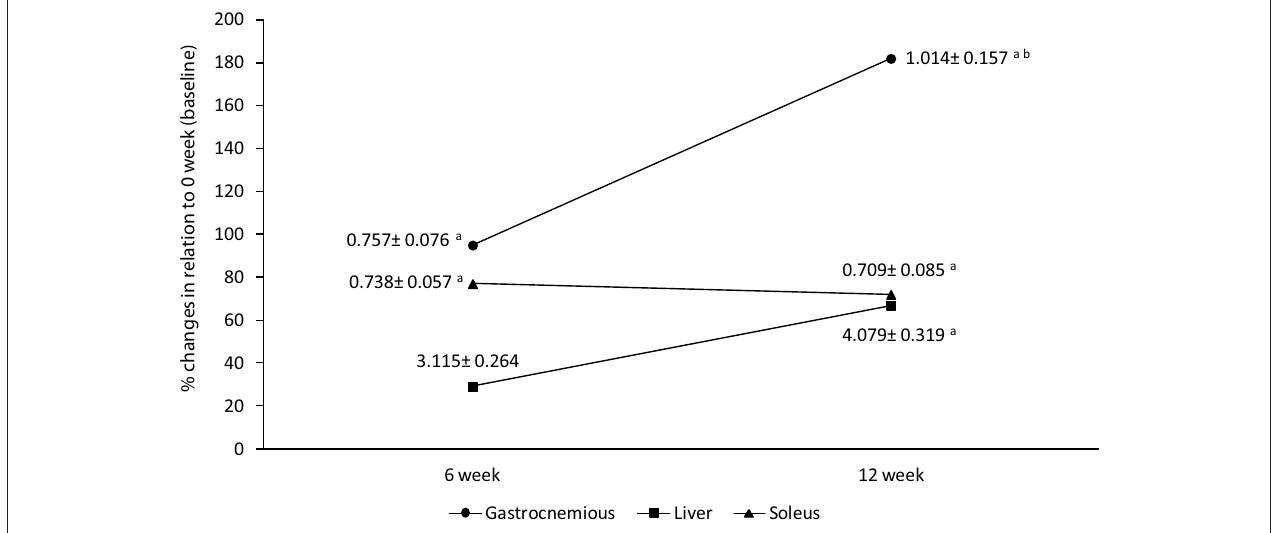
Liver Soleus FIGURE 3 | Percentage differences in soleus, liver, and gastronemius tissues when compared to 0 week (baseline). Data labels are presented in mean ± standard error (mg/100 mg). a Significantly different ( P < 0.05) in relation to baseline. b Significantly different ( P < 0.05) in relation to HIIT short term.